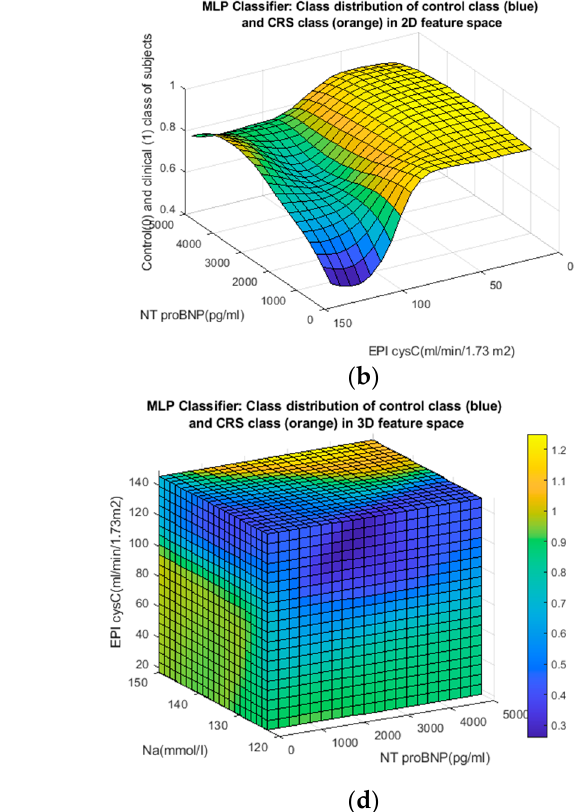
Figure 8d. MLP classifiers and those based on fuzzy logic are suitable for generalization in multidimensional space.